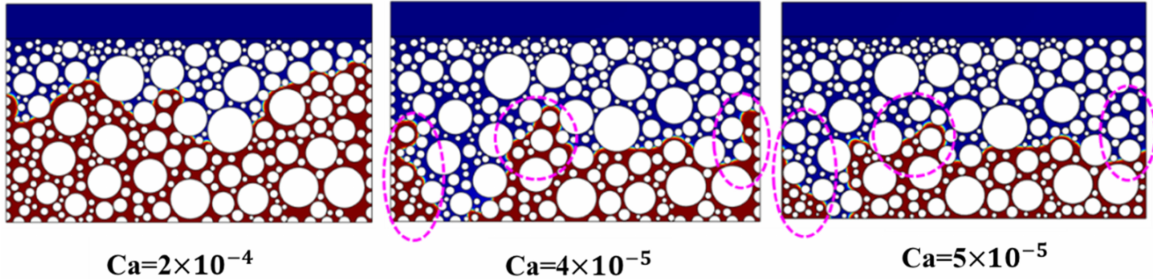
Figure 17. Oil-water distribution at the end of imbibition with different oil-water interfacial tensions.